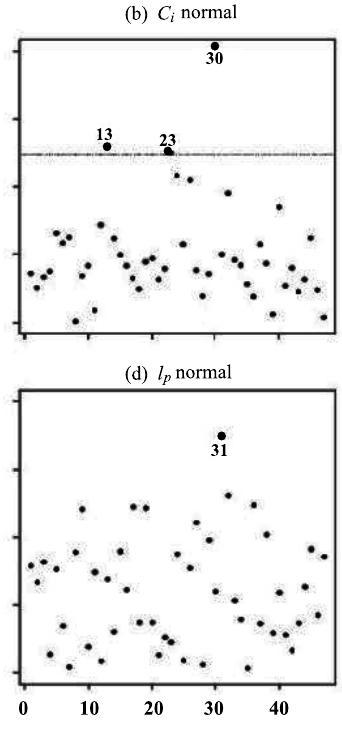
Figure 2. Graphs C and l for soybean yield. i p Table 4. Descriptive statistics for the variables Prod, Prod (13) and Prod